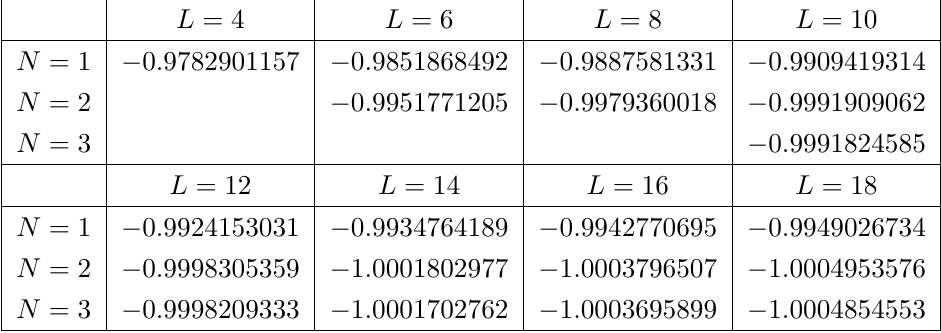
Table 7 . Pad(cid:19)e extrapolation values for the vacuum energy in Siegel gauge, from L = 4 to L = 18. The value of the entries where (4 N (cid:0) 2 = L ) coincide with the direct ( L; 3 L ) level-truncation computations.